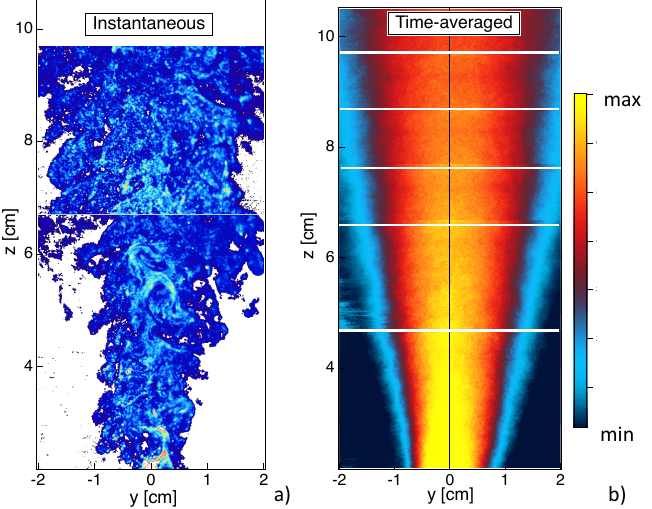
Figure 8. Localization of TiO 2 nanoparticles via light scattering measurements. Instantaneous ( a ) and time-averaged ( b ) fields. Time-averaged field is reconstructed by assembling series of measurements at six vertical positions of the laser